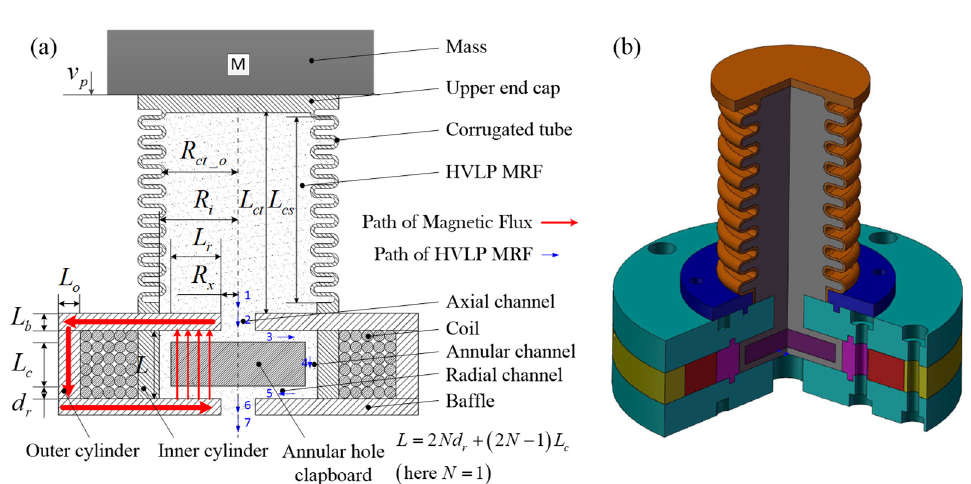
Figure 1. Schematic of an HVLP MRF-based MREA with radial flow mode: ( a ) two-dimensional and ( b ) three-dimensional models. HVLP: high-viscosity linear polysiloxane; MRF: magnetorheological fluid; MREA: magnetorheological energy